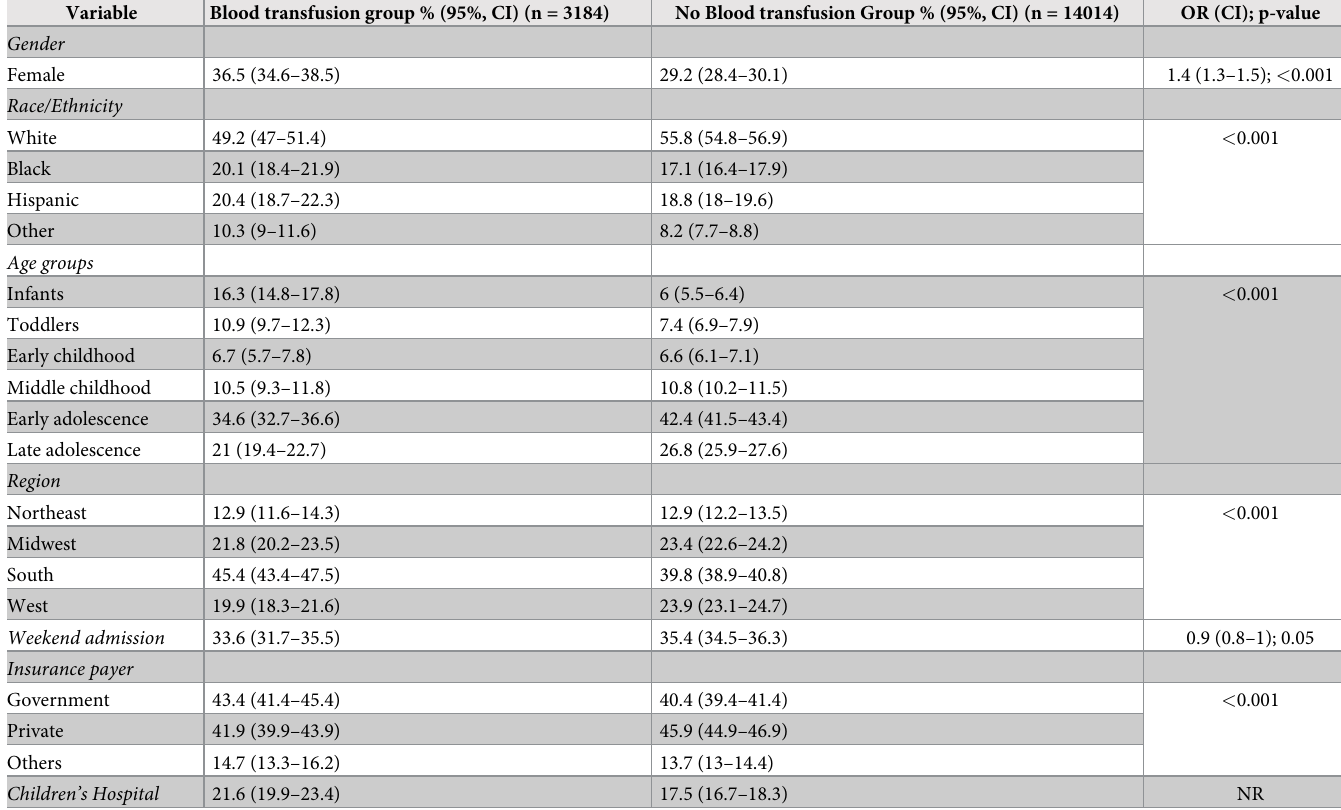
Table 1. Differences in demographic variables among children with traumatic brain injury and mechanical ventilation with and without blood transfusion therapy. The values are presented as percentages (95% Confidence intervals). Variable Blood transfusion group % (95%, CI) (n = 3184) No Blood transfusion Group % (95%, CI) (n = 14014) OR (CI);